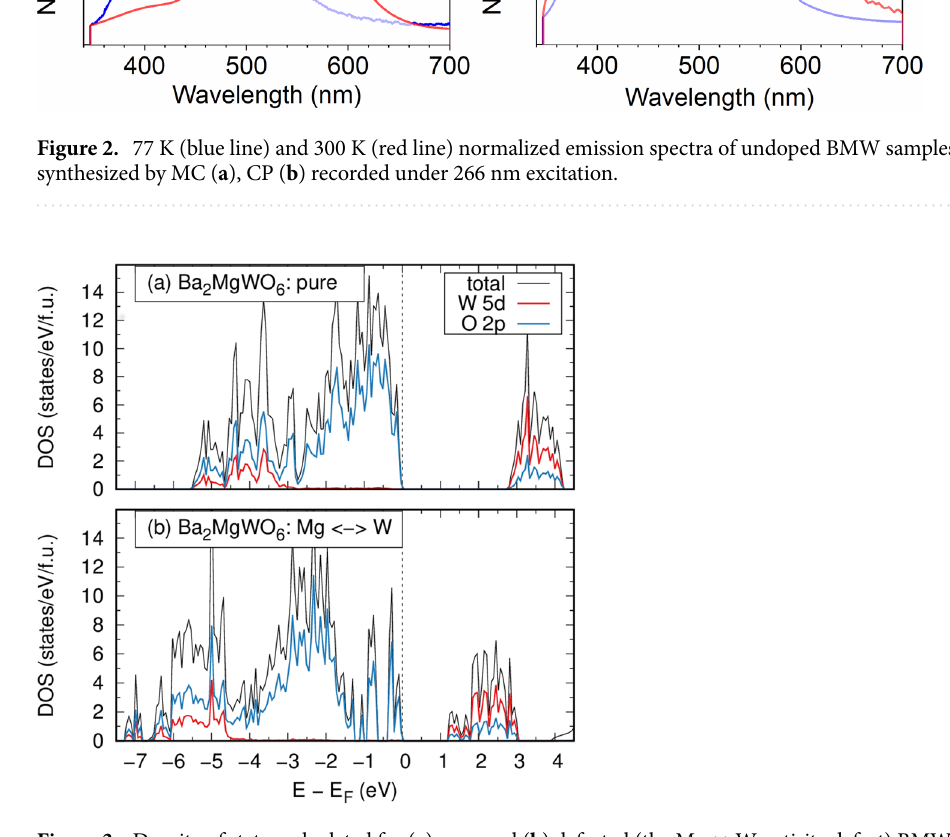
Figure 3. Density of states calculated for ( a ) pure and ( b ) defected (the Mg ↔ W antisite defect) BMW double perovskite